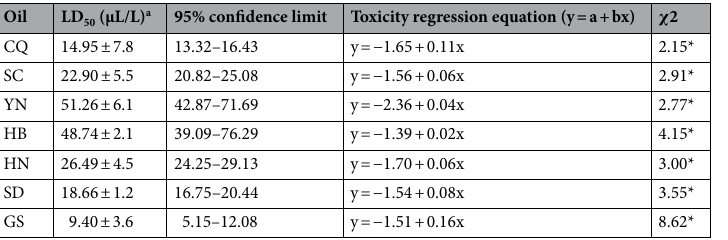
Table 4. Fumigation toxicity of the essential oils extracted from seven geographical regions of Ar. argyi in China against female adults of An. sinensis . a Determined with at least 6 concentrations at μL/L. *Significant at p < 0.05. CQ, SC, YN, HB, HN, SD and GS: essential oils from Chongqing, Sichuan, Yunnan, Hubei, Henan, Shandong and Gansu province/municipality,